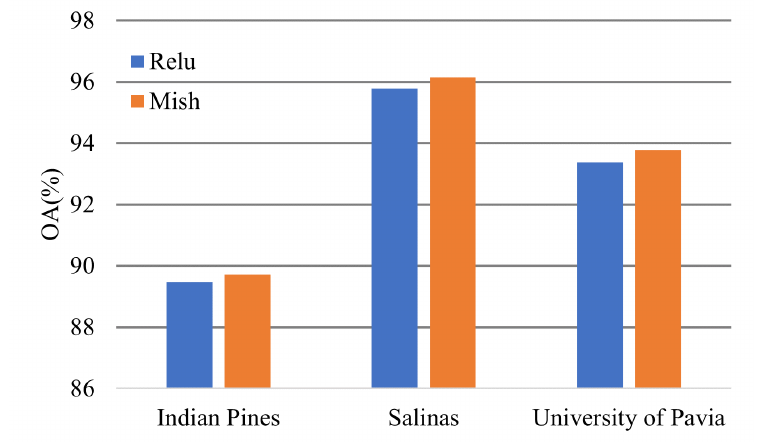
Figure 19. Effectiveness of the activation